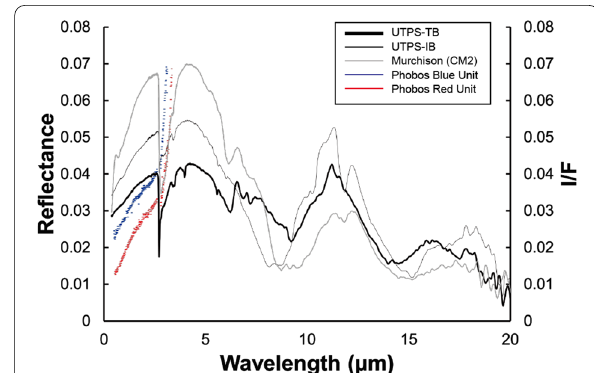
Fig. 6 Reflectance spectra for UTPS‑TB, ‑IB, and the Murchison meteorite compared with Phobos I/F spectra (red and blue units; data extracted from Fig. 4 of Fraeman et al. 2012)